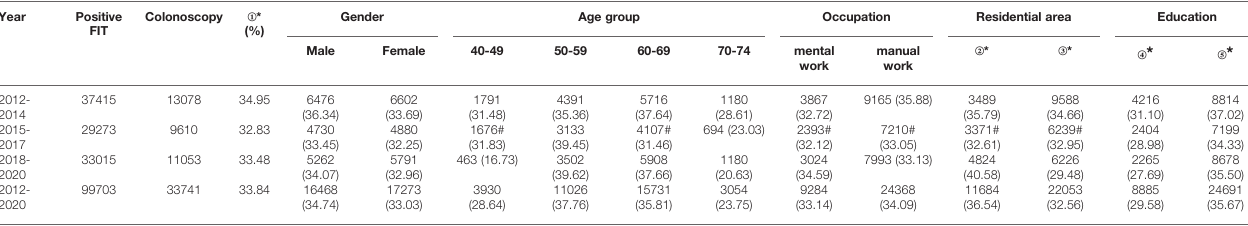
TABLE 8 | Analysis of compliance results of subsequent colonoscopy in positive FIT participants, (n,%). Year Positive